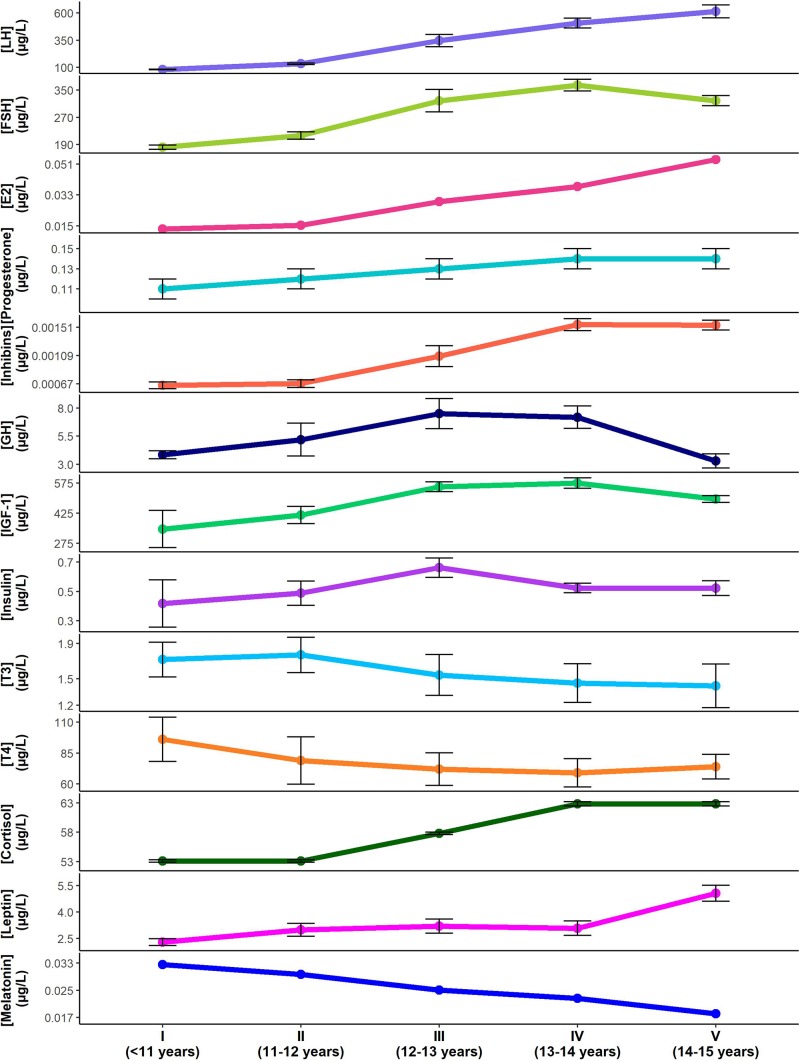
Changes in pubertal hormone levels according to Tanner stage and approximate age (mean ± standard error). Hormone concentrations for luteinizing hormone (LH) (Burger et al., 1988). follicle stimulating hormone (FSH) (Burger et al., 1988), Estradiol (E2) (Wennink et al., 1990), progesterone (Apter, 1980), inhibins (Wennink et al., 1990), growth hormone (GH) (Rose et al., 1991), insulin-like growth factor-1 (IGF-1) (Moran et al., 2002), insulin (Moran et al., 2002), triiodothyronine (T3) (Elmlinger et al., 2001), thyroxine (T4) (Elmlinger et al., 2001), cortisol (Stroud et al., 2011), leptin (Ahmed et al., 1999), melatonin (Crowley et al., 2012) are shown through the Tanner stages for females. Note that standard errors were not available for estradiol or melatonin data. Standard errors for LH, FSH and inhibins were approximated based on data provided. Cyclical changes in hormone levels with menstruation are not reflected.